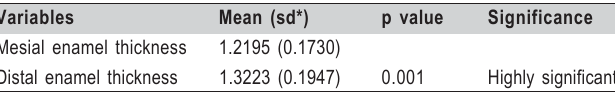
Table 3 - Comparative analysis of the measurements obtained for mesial (n = 40) and distal (n = 40) mean enamel